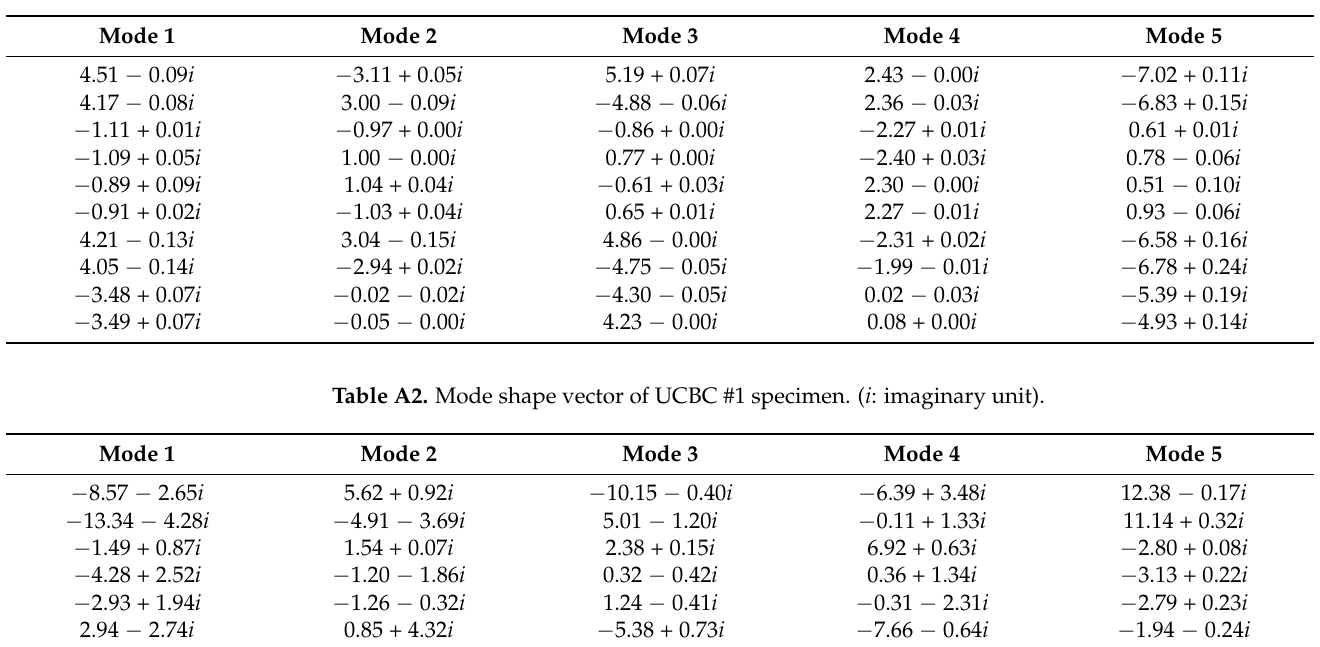
Table A1. Mode shape vector of SUS304 specimen. ( i : imaginary unit).